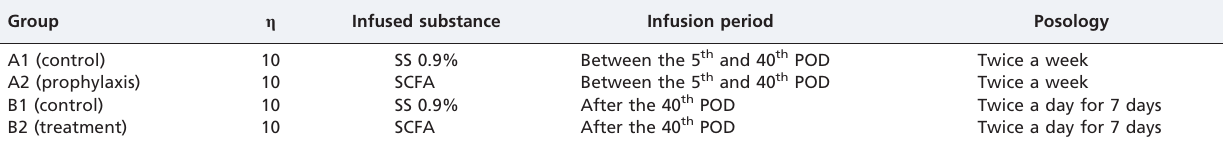
Table 1 - Experimental design. Distribution of animal groups according to type of intervention, treatment period, and posologies.